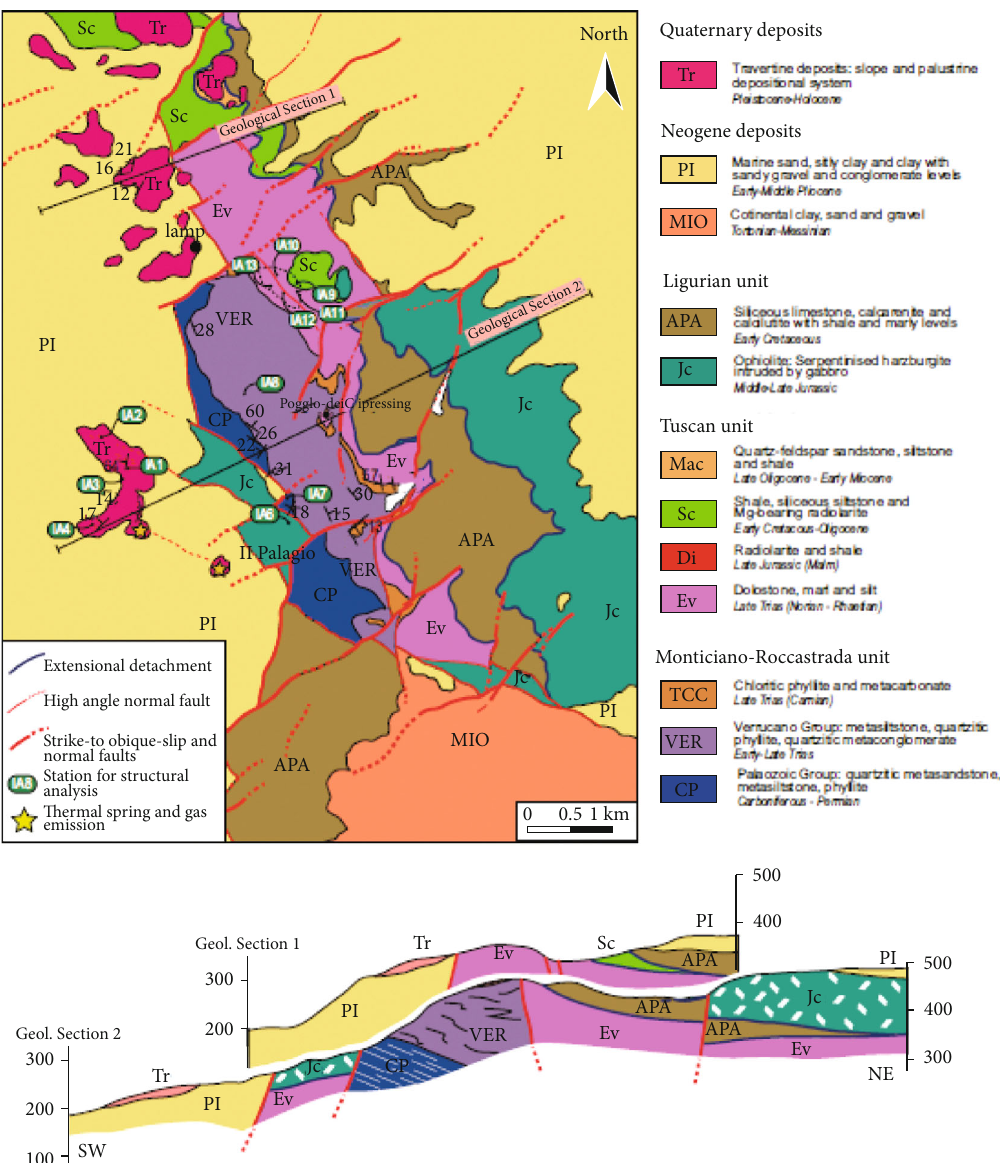
Figure 2: Geological map of the Iano area and related geological